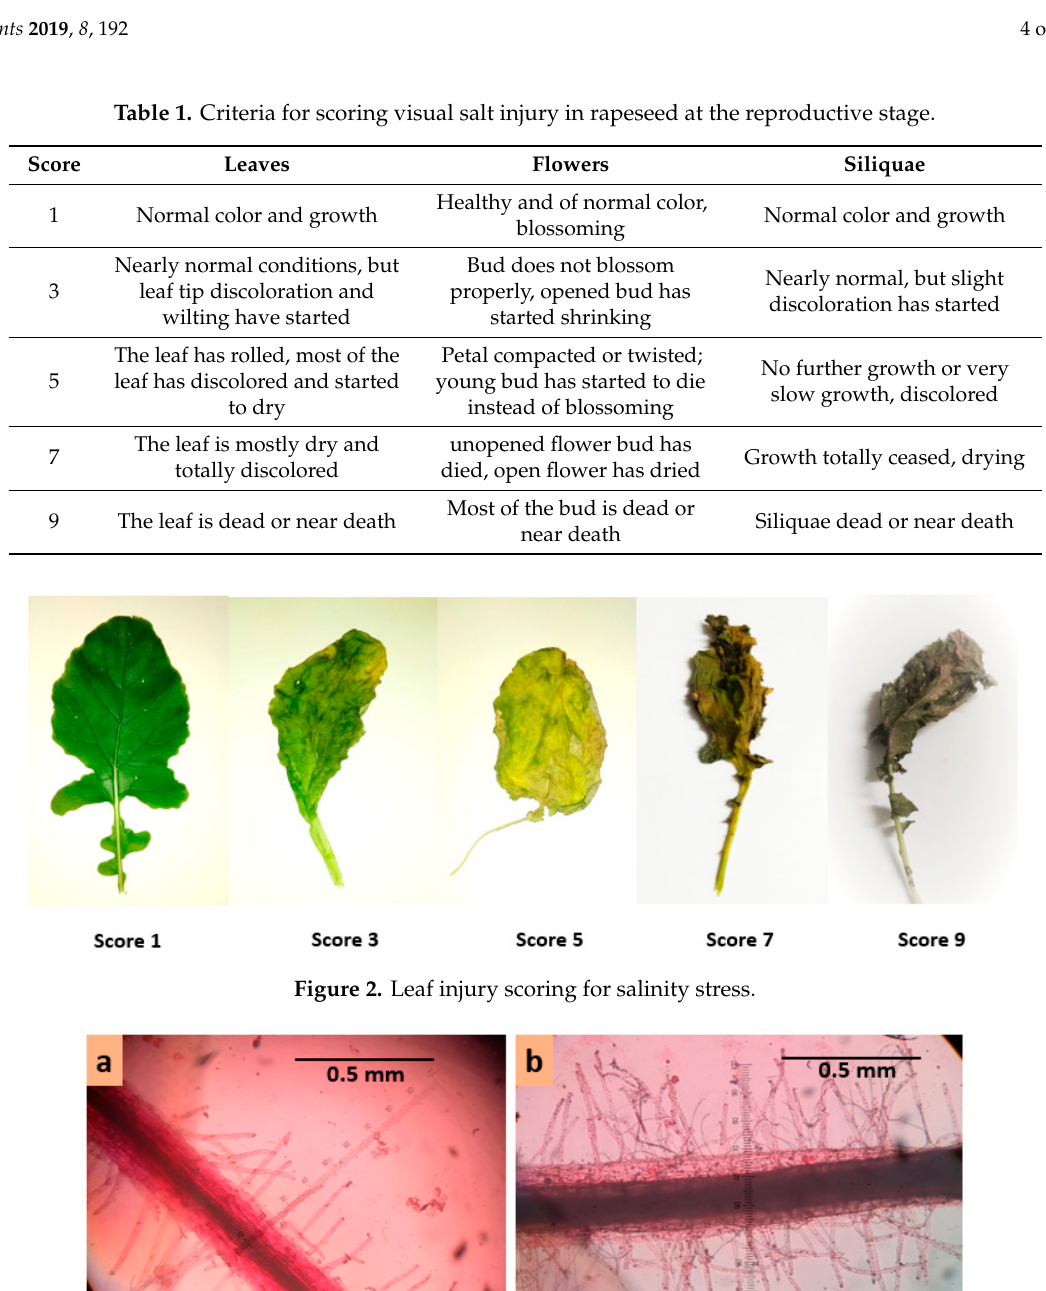
Table 1. Criteria for scoring visual salt injury in rapeseed at the reproductive stage.